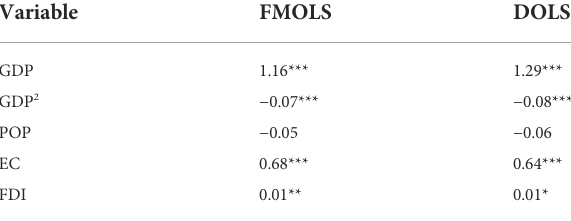
TABLE 6 Results of FMOLS and DOLS.